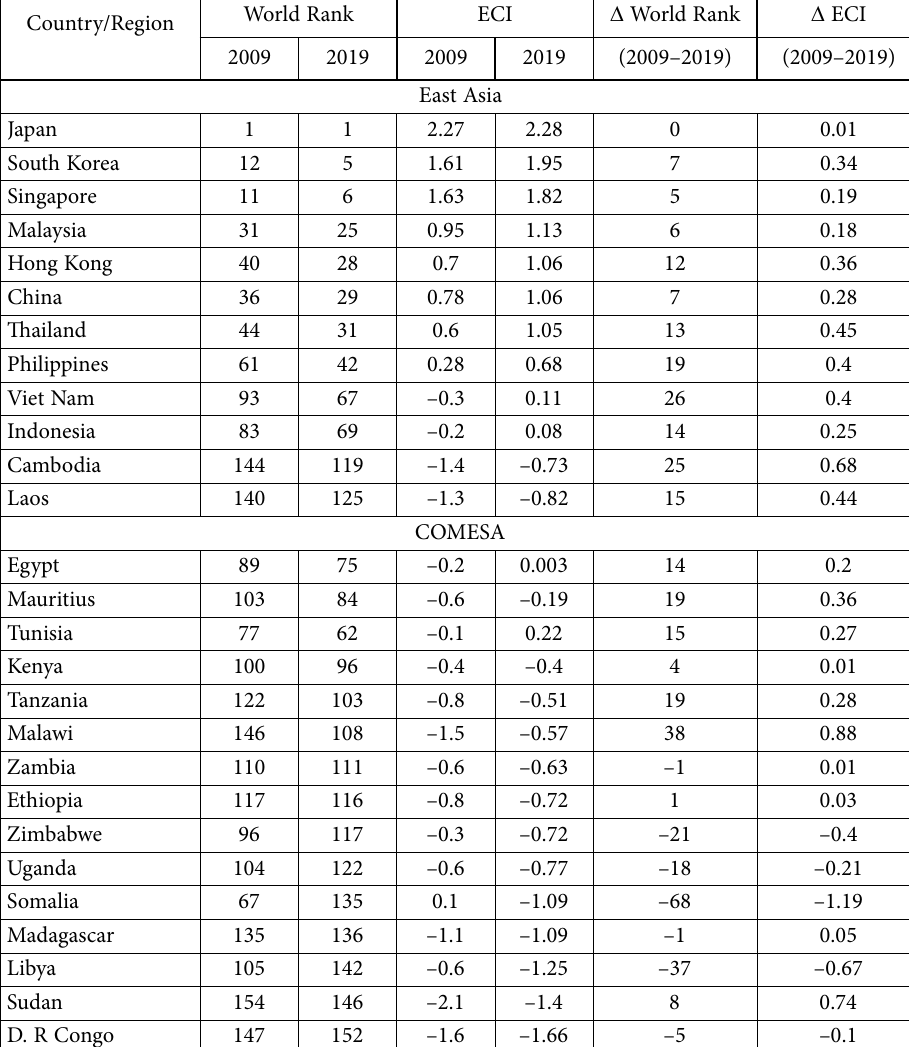
Table 2. The progress of economic complexity and world rankings 2009–2019 (source: authors’ calculation using data from OEC, 2020) Country/Region World